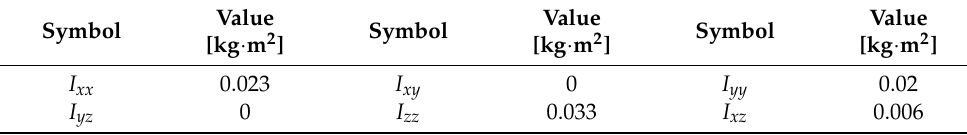
Table 6. Mass moment of inertia of the